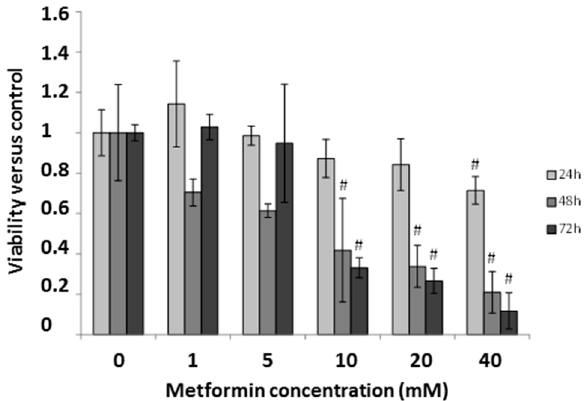
Figure 6. The effect of metformin on MDA-MB-231 cell line viability at different time-points and concentrations. Error bars represent the standard deviation of triplicate experiments. Statistically significant differences are shown for the comparison between treated cells and the control (not treated) at respective time-points (Student t test: # p < 0.001).